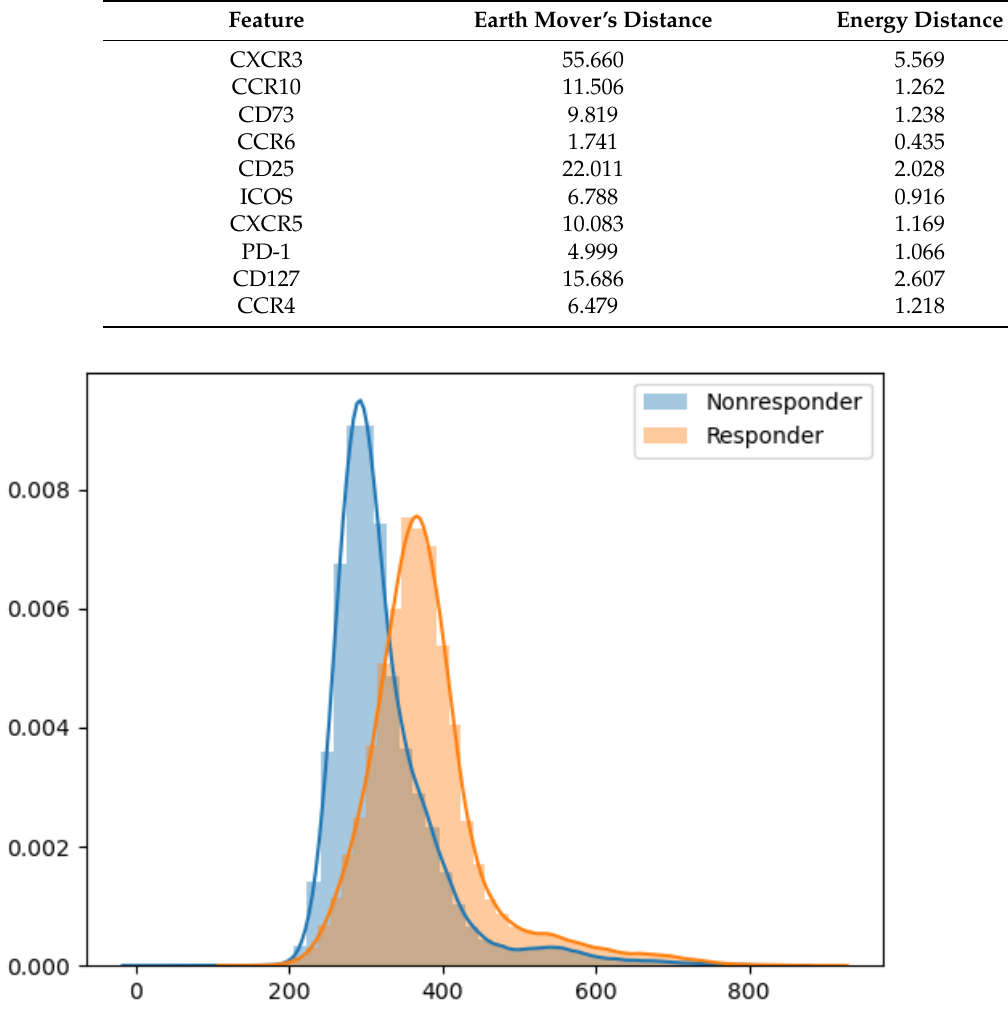
Figure 10. Probability distribution functions (PDFs) for CXCR3 compensated fluorescence intensities, compared in responders and nonresponders. (Adaptive panel, Naïve CD4+ T cells, day 1).